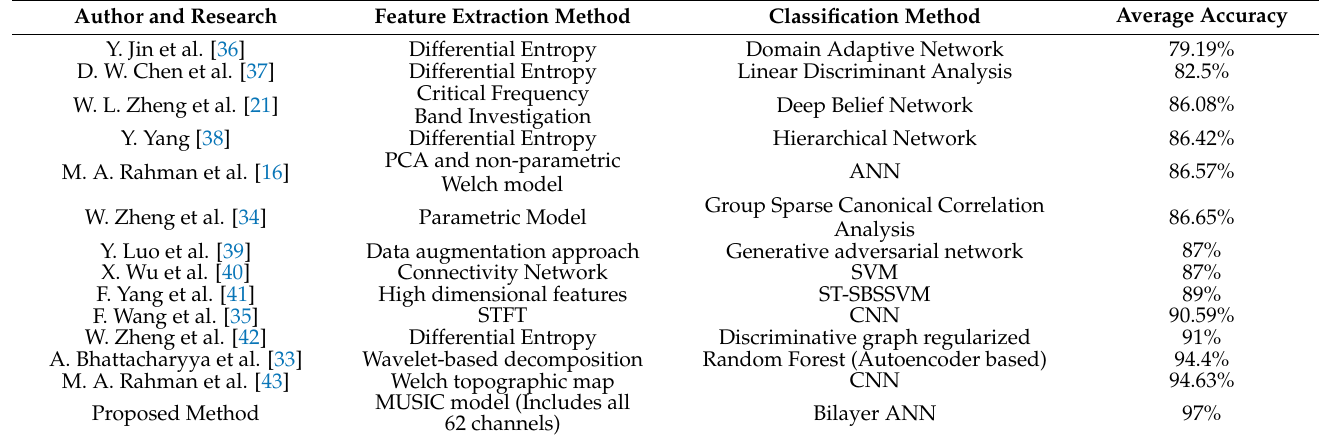
Table 2. Performance comparison with existing research on emotional state classification for the seed dataset.